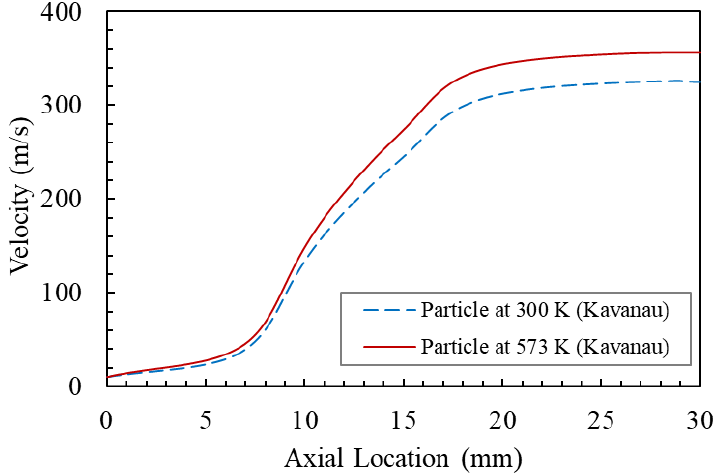
Figure 19. Effect of inlet temperature on particle velocity upon impact, 𝑑 𝑝 = 5 μm .